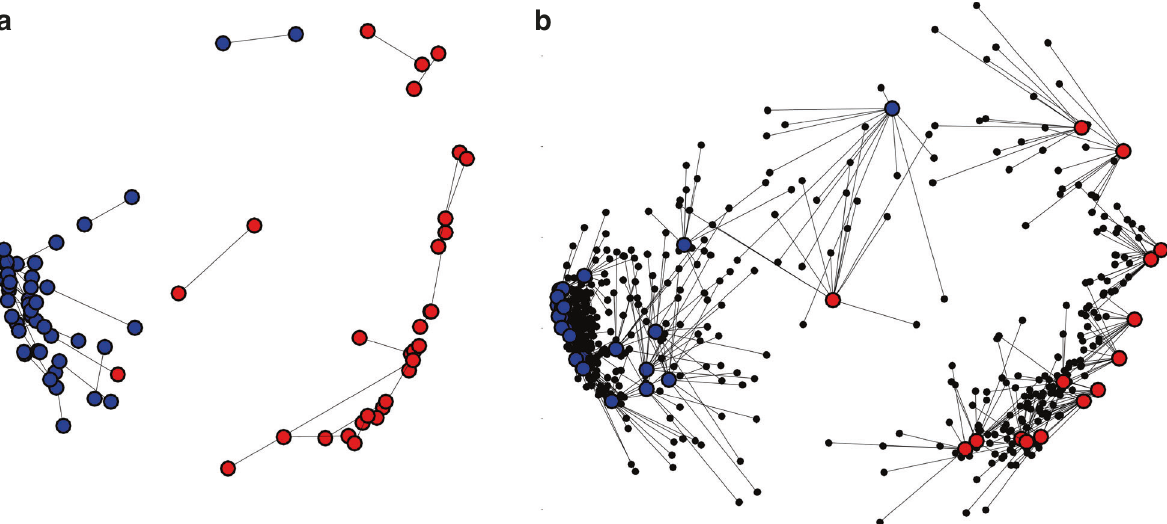
Fig. 3 Consistency of pulvino-cortical coupling between hemispheres and across individuals. a Multidimensional scaling for left and right hemisphere pulvino-cortical functional connectivity. Procrustes analysis was performed to align MDS of the left hemisphere to the right hemisphere. Lines illustrate the distances between areas matched between hemispheres. Dots were color-coded based on clustering performed on each hemisphere separately. The only difference in clustering between hemispheres was area pSTS (i.e., the only blue and red dots linked by a line). b MDS for each subject ’ s pulvinar connectivity (averaged across hemisphere). Procrustes analysis was performed to align MDS of each subject to the group average. Small black dots illustrate the locations of individual subject areas. Lines illustrate distances of between individual subjects and the group average for matched areas. Dots were color-coded based on clustering performed on the group average